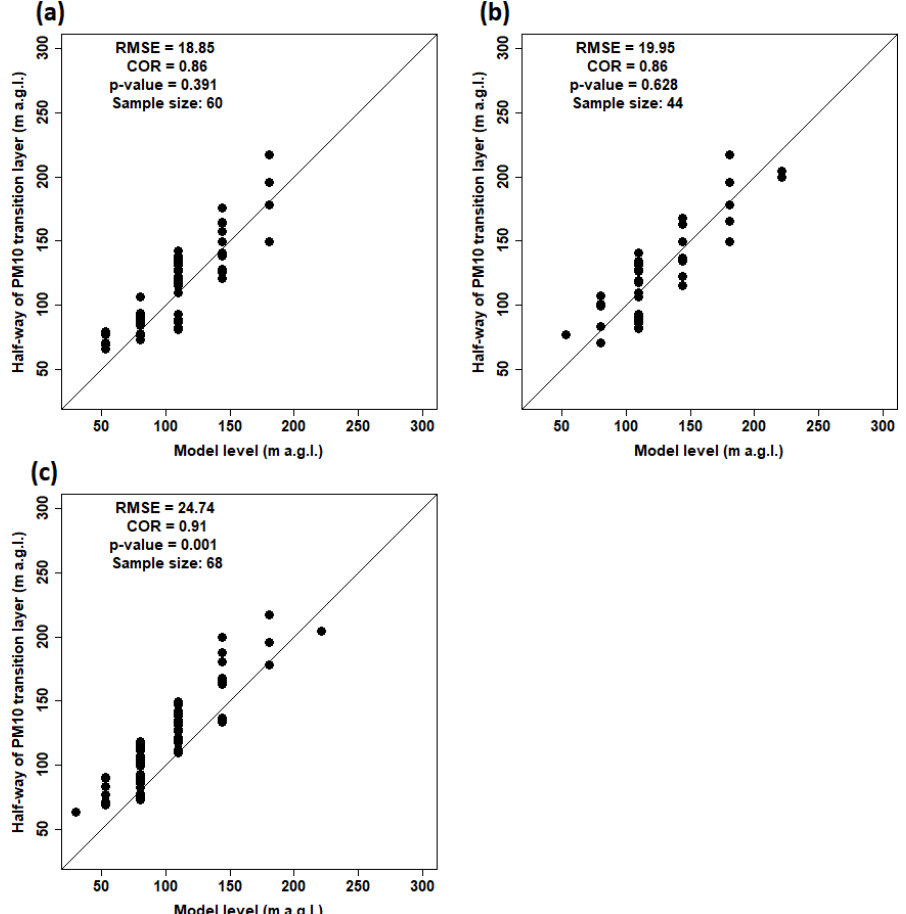
Figure 11. The observed height of half-way altitude of the PM 10 concentration’s transition layer and (a) predicted height of the convection layer, (b) the strong wind shear speed, and (c) wind shear direction. Explanations: RMSE: root mean square error, COR: Pearson correlation coefficient, p value: p value calculated with the Mann–Whitney U